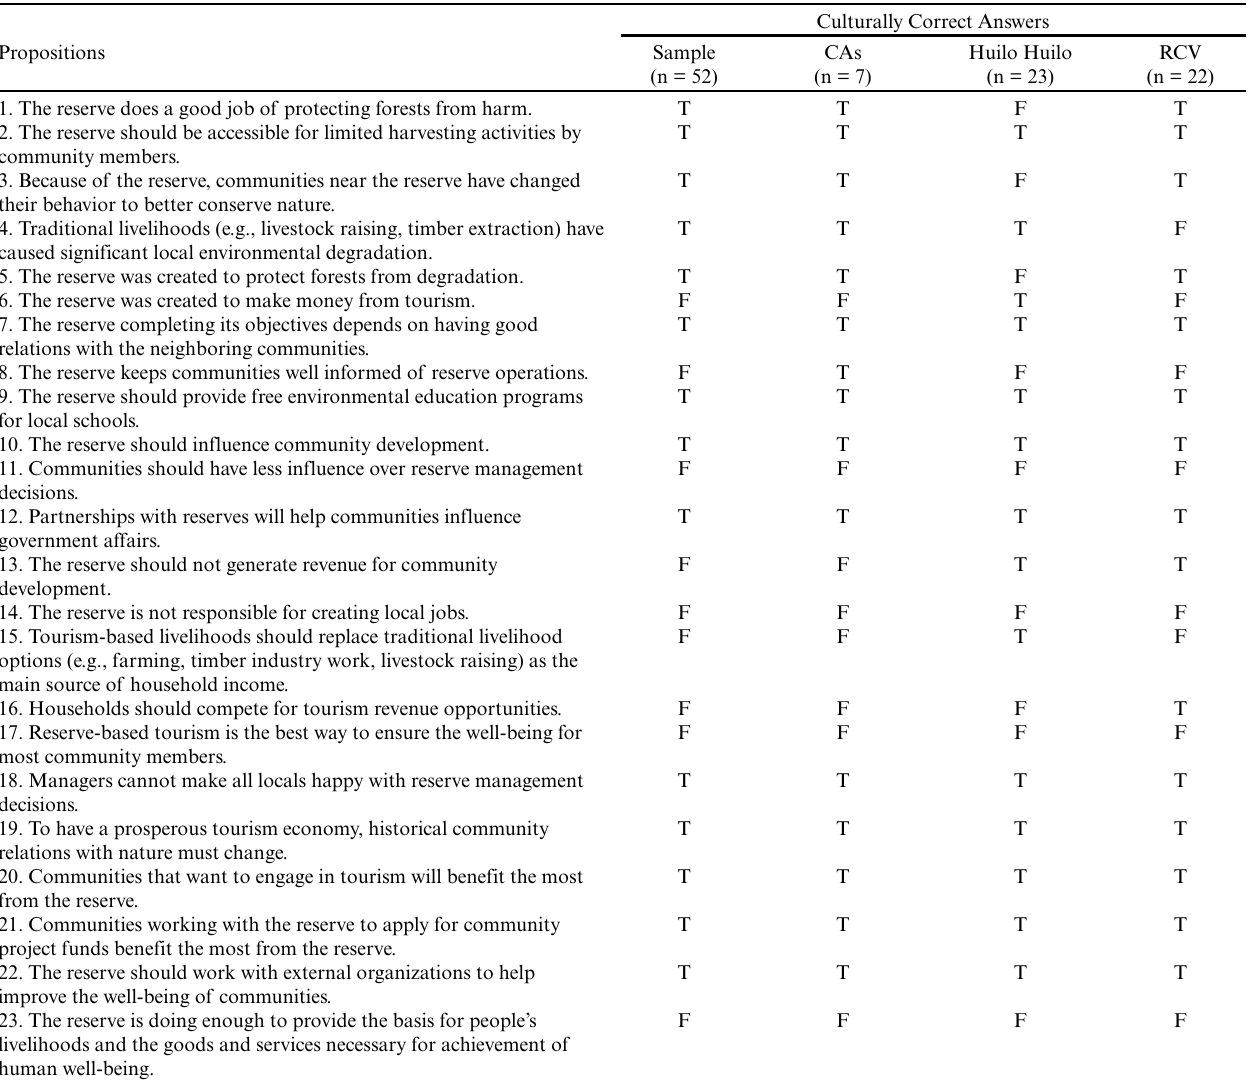
Table 2 . Large-scale private protected area (PPA) propositions and their culturally correct answers. (CA = conservation agents, HH = Huilo Huilo Reserve, RCV = Valdivian Coastal